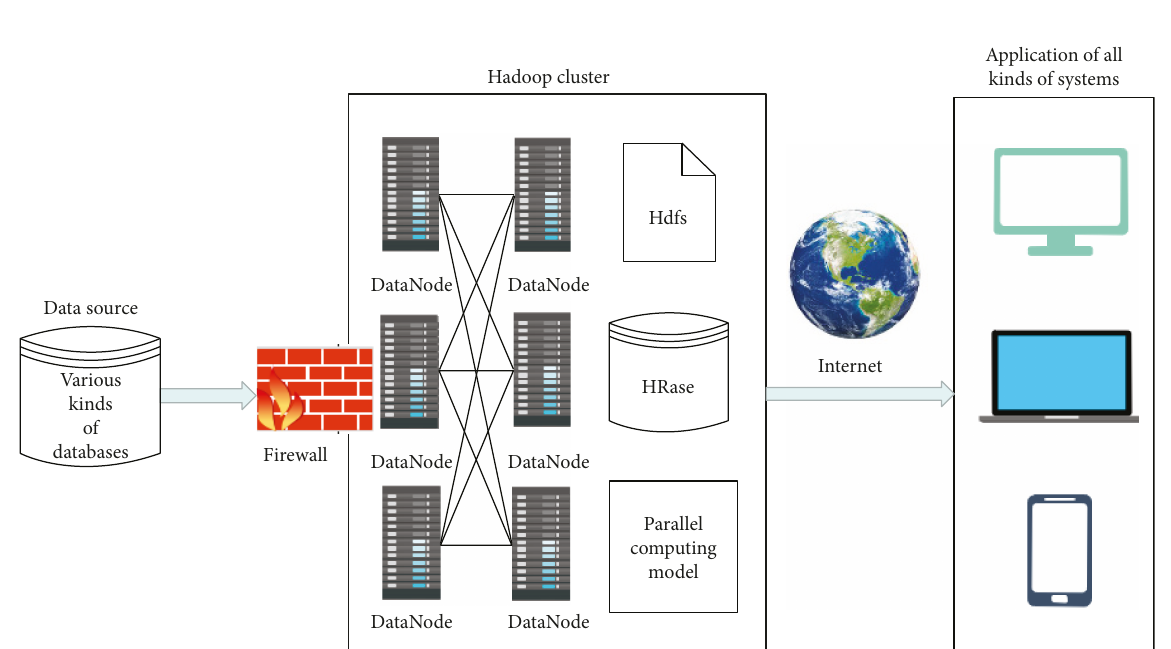
Figure 2: Frame composition of large data platform based on